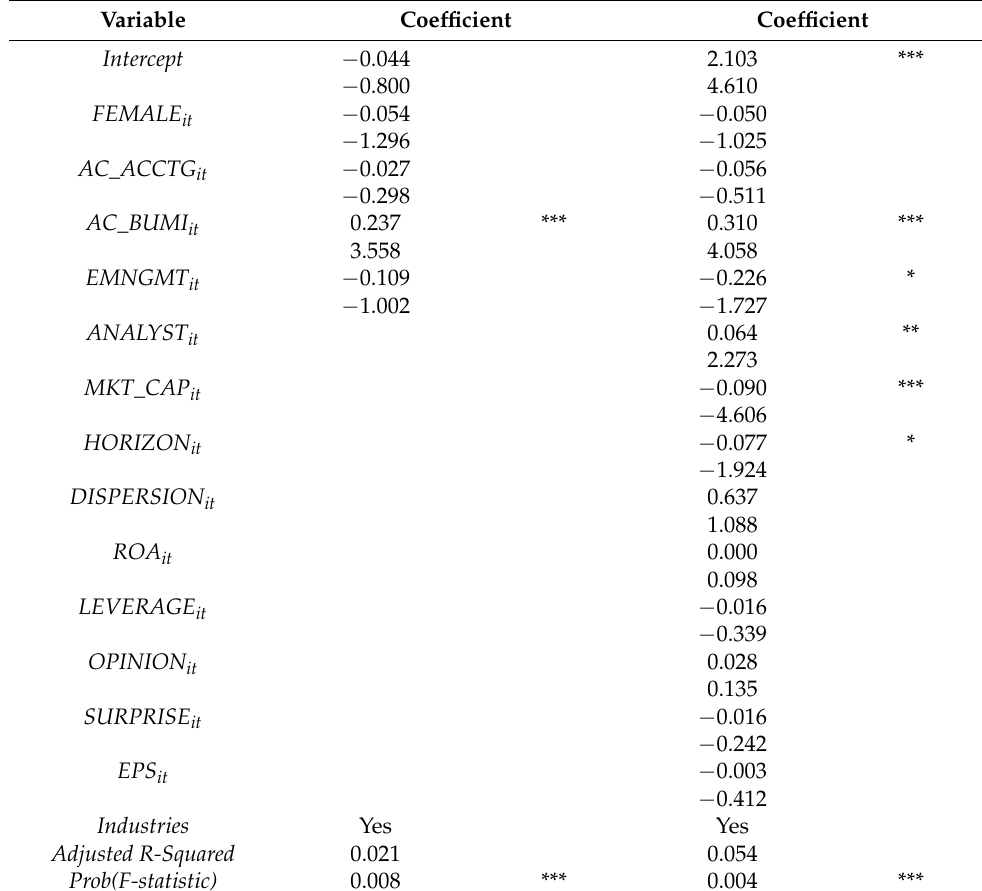
Table 6. Test Results of H1–H3: Regression Analysis of Analyst Forecast Accuracy and Audit Committee